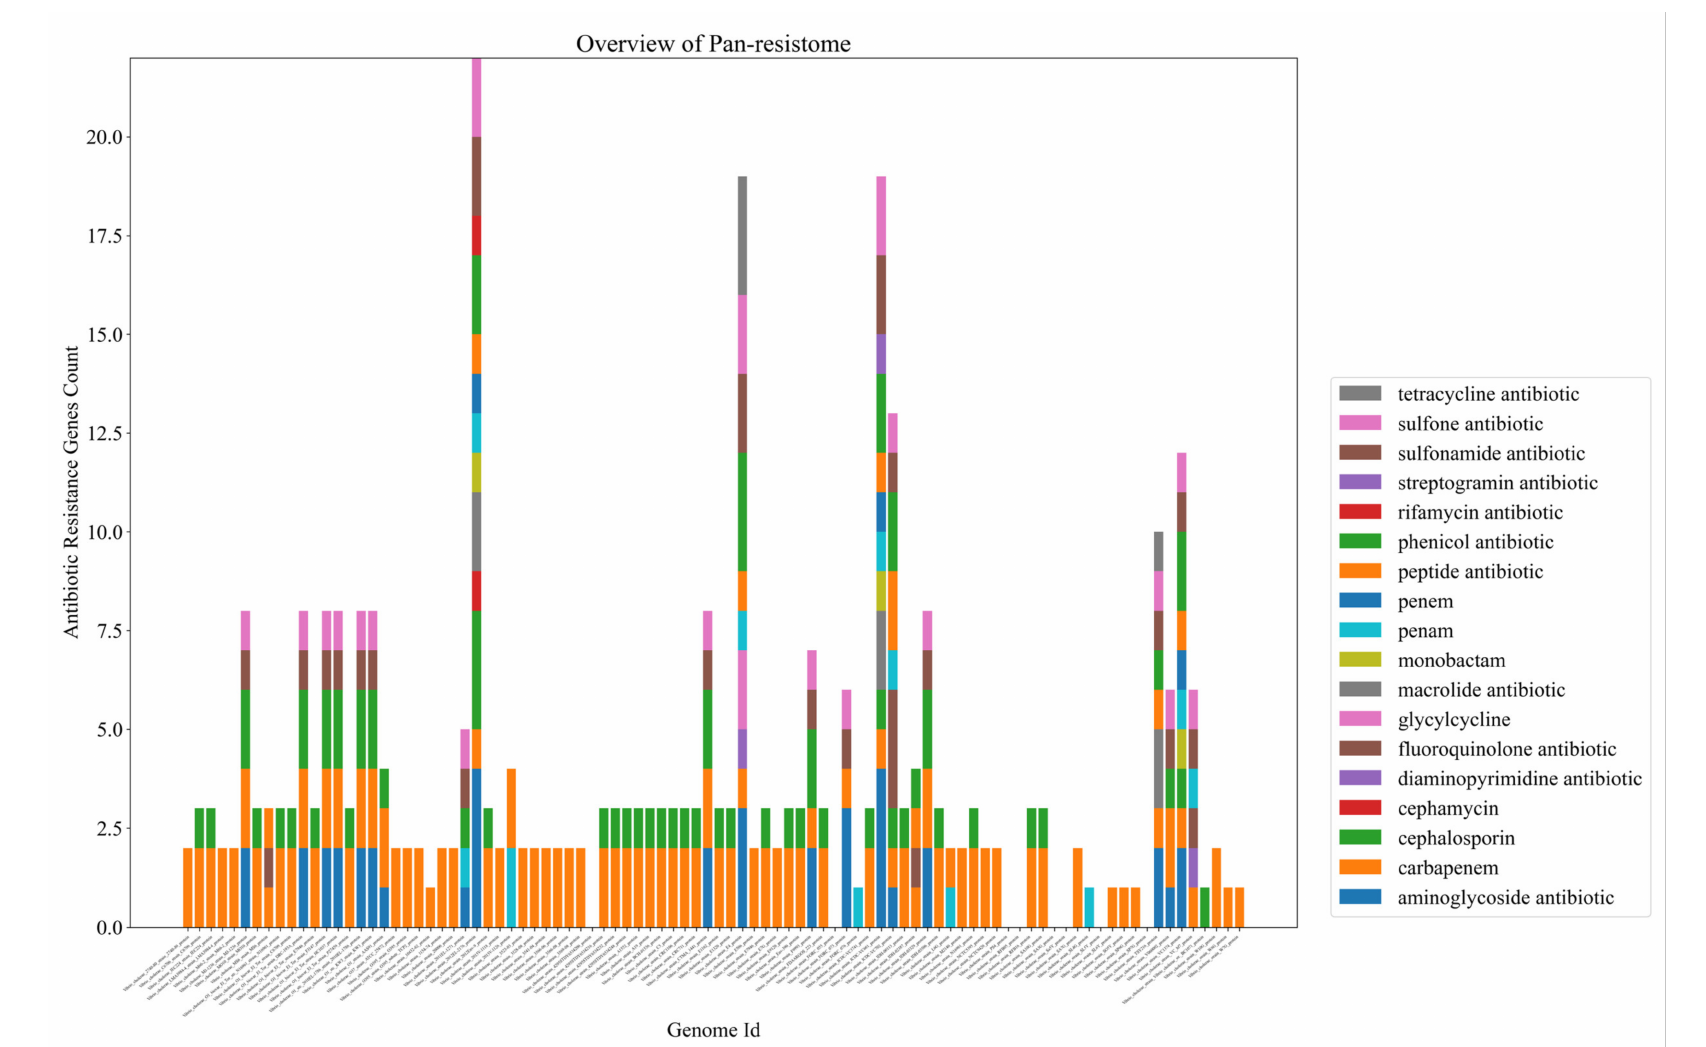
Figure 5. An overview of the pan-resistome of Vibrio cholerae . A total of 92 complete genomes were used for ARG